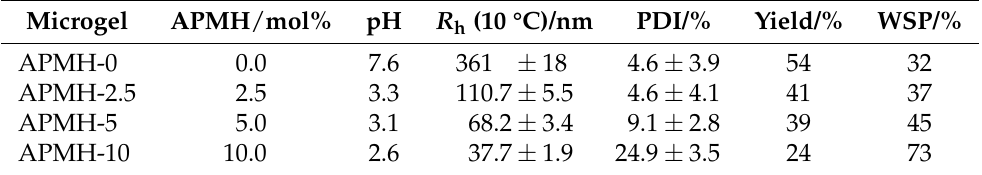
Table 1. Overview of the synthesized poly(NIPAM- co -APMH) microgels with different amounts of APMH (feed), with respect to the molar amount of NIPAM. Additionally, the reaction pH prior to initiation, hydrodynamic radii ( R h ) and polydispersities (PDI) at 10°C, microgel yield and amount of water soluble polymer (WSP) in the supernatant of the first centrifugation step are shown.